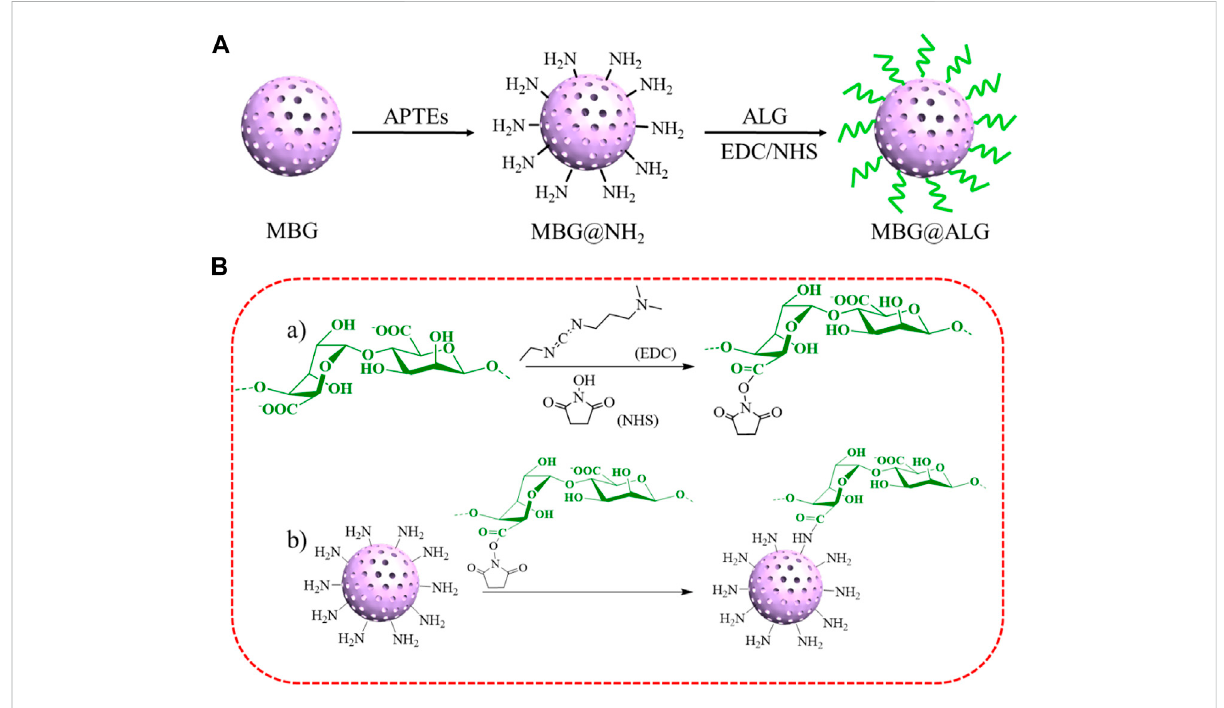
FIGURE 1 Schematic illustration of the construction of MBG@ALG (A) and reaction scheme (B)